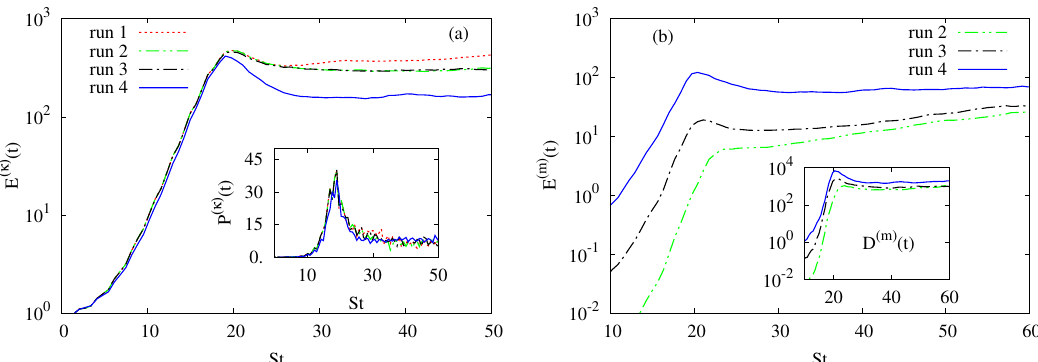
Figure 4. ( a ) Time development of kinetic energy E ( κ ) ( t ) normalized by its initial value in the PHT case (run 1) and the PMHDT cases (runs 3–4). The inset shows the time development of kinetic production rate P ( κ ) for the same runs. ( b ) Time development of magnetic energy E ( m ) ( t ) normalized by E ( κ ) ( 0 ) in the PMHDT cases (runs 2–4). The inset shows the time development of magnetic dissipation rate D ( m ) normalized by D ( κ ) ( 0 ) for the same